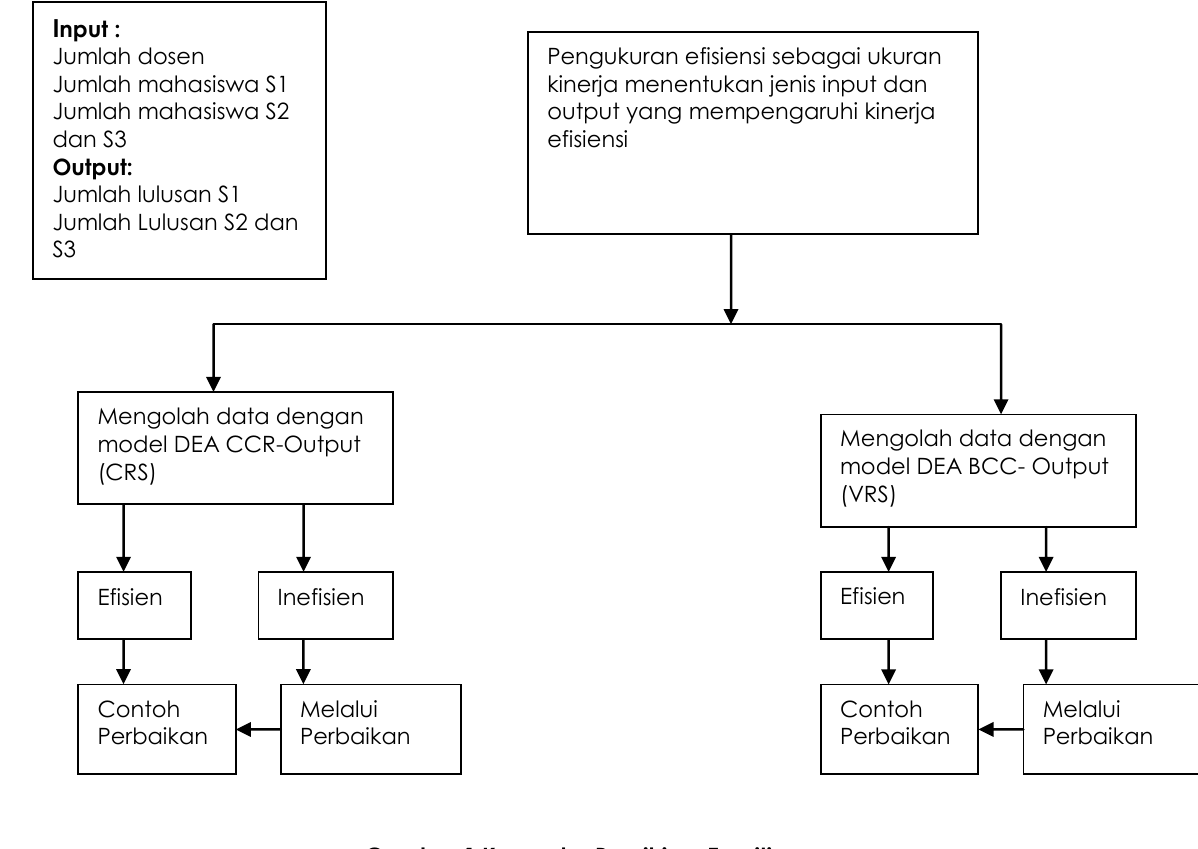
Teknik Analisis